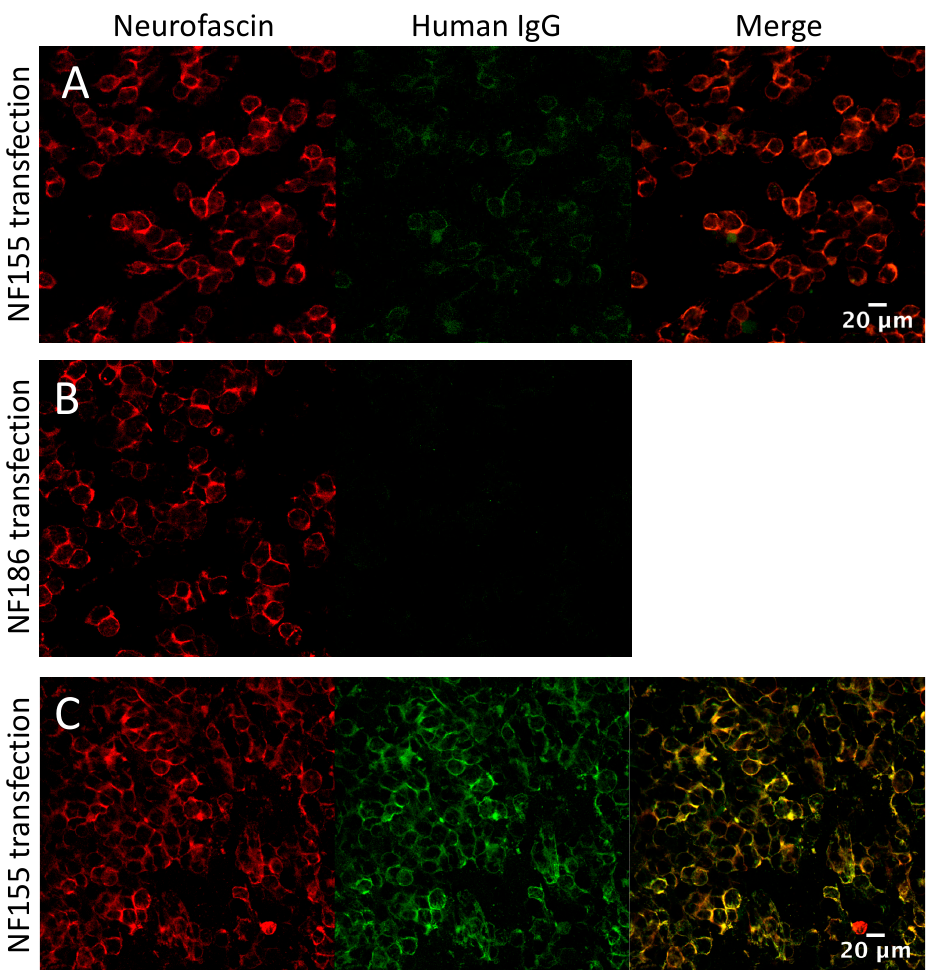
Figure 4. Nodal / paranodal cell-based assays. ( A ) MS / CIS eluate weakly positive on the neurofascin-155 Figure 4. Nodal/paranodal cell-based assays. ( A ) MS/CIS eluate weakly positive on the neurofascin- CBA at 1:100 (Score 2 + , end-point titre 1:200) and ( B ) negative on the neurofascin-186 CBA. ( C ) Strong 155 CBA at 1:100 (Score 2+, end-point titre 1:200) and ( B ) negative on the neurofascin-186 CBA. ( C ) positive at 1:100 (Score 4 + , end-point titre 1:3200) from the antibody positive CIDP cohort shown Strong positive at 1:100 (Score 4+, end-point titre 1:3200) from the antibody positive CIDP cohort for shown for comparison.